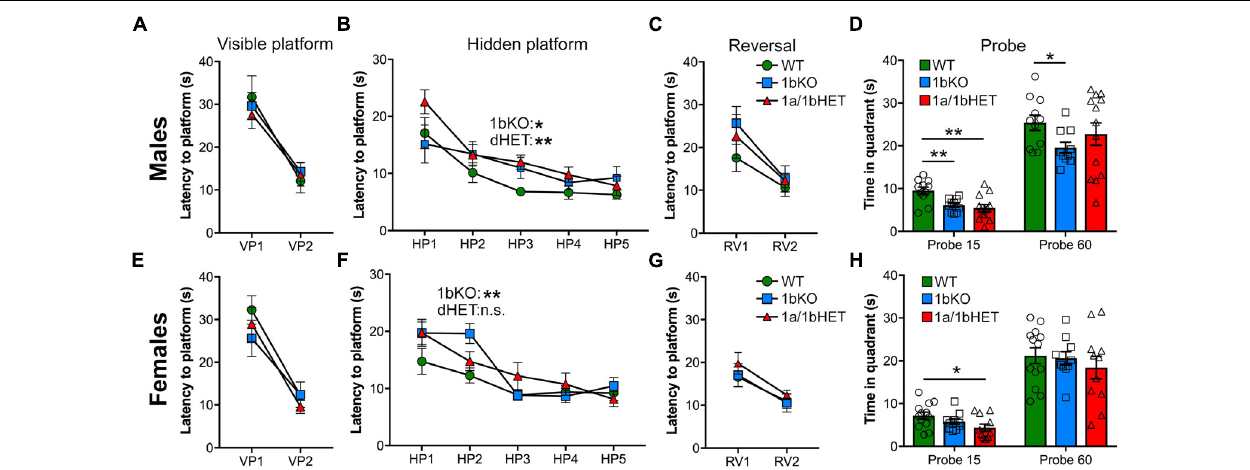
FIGURE 4 | CC2D1B is involved in spatial memory formation and retention with mild male-specificity. Hippocampus-dependent spatial memory was assessed in 1bKO and 1a/1bdHET mice via the Morris Water Maze test. Spatial learning was measured as latency to escape in three different stages, visible platform (VP), hidden platform (HP), or the reversal (RV) of the HP position. No deficits were shown by males (A) or females (E) of any genotype in identifying the platform in the VP trial. (B) Both 1bKO and 1a/1bHET males showed a delay in learning the location of the HP, and a similar deficit was present in 1bKO females (F) . (C,G) No differences were found in the RV during the test. (D,H) Spatial memory retention was measured between the HP and RV trials by the time spent swimming in the quadrant where the platform was previously located. Significant spatial memory impairment was found in the 1bKO male mice compared to WT both during the first 15 s and at the end of the trial after 60 s, while female 1bKO mice showed no deficit. 1a/1bHET males and females spent less time looking for the platform during the first 15 s, but subsequently recovered. Two-way ANOVA with repeated measures was used for analysis of the HP phase. Multiple t -tests with equal variance were uses for individual timepoints and probe analysis ∗ p < 0.05, ∗∗ p <